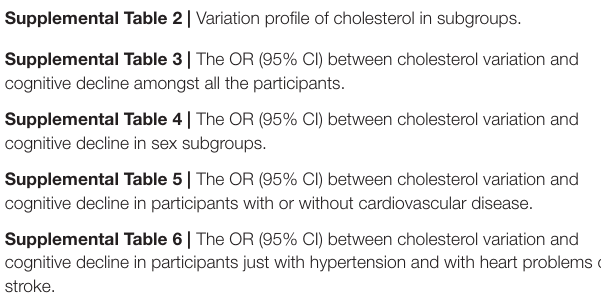
Supplemental Table 1 | Characteristics between included and excluded participants. Supplemental Table 2 | Variation profile of cholesterol in subgroups.